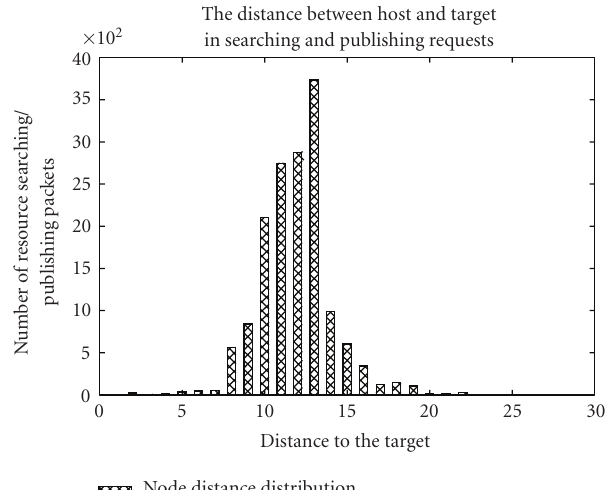
Figure 5: The distance distribution of searching and publishing re- quests.